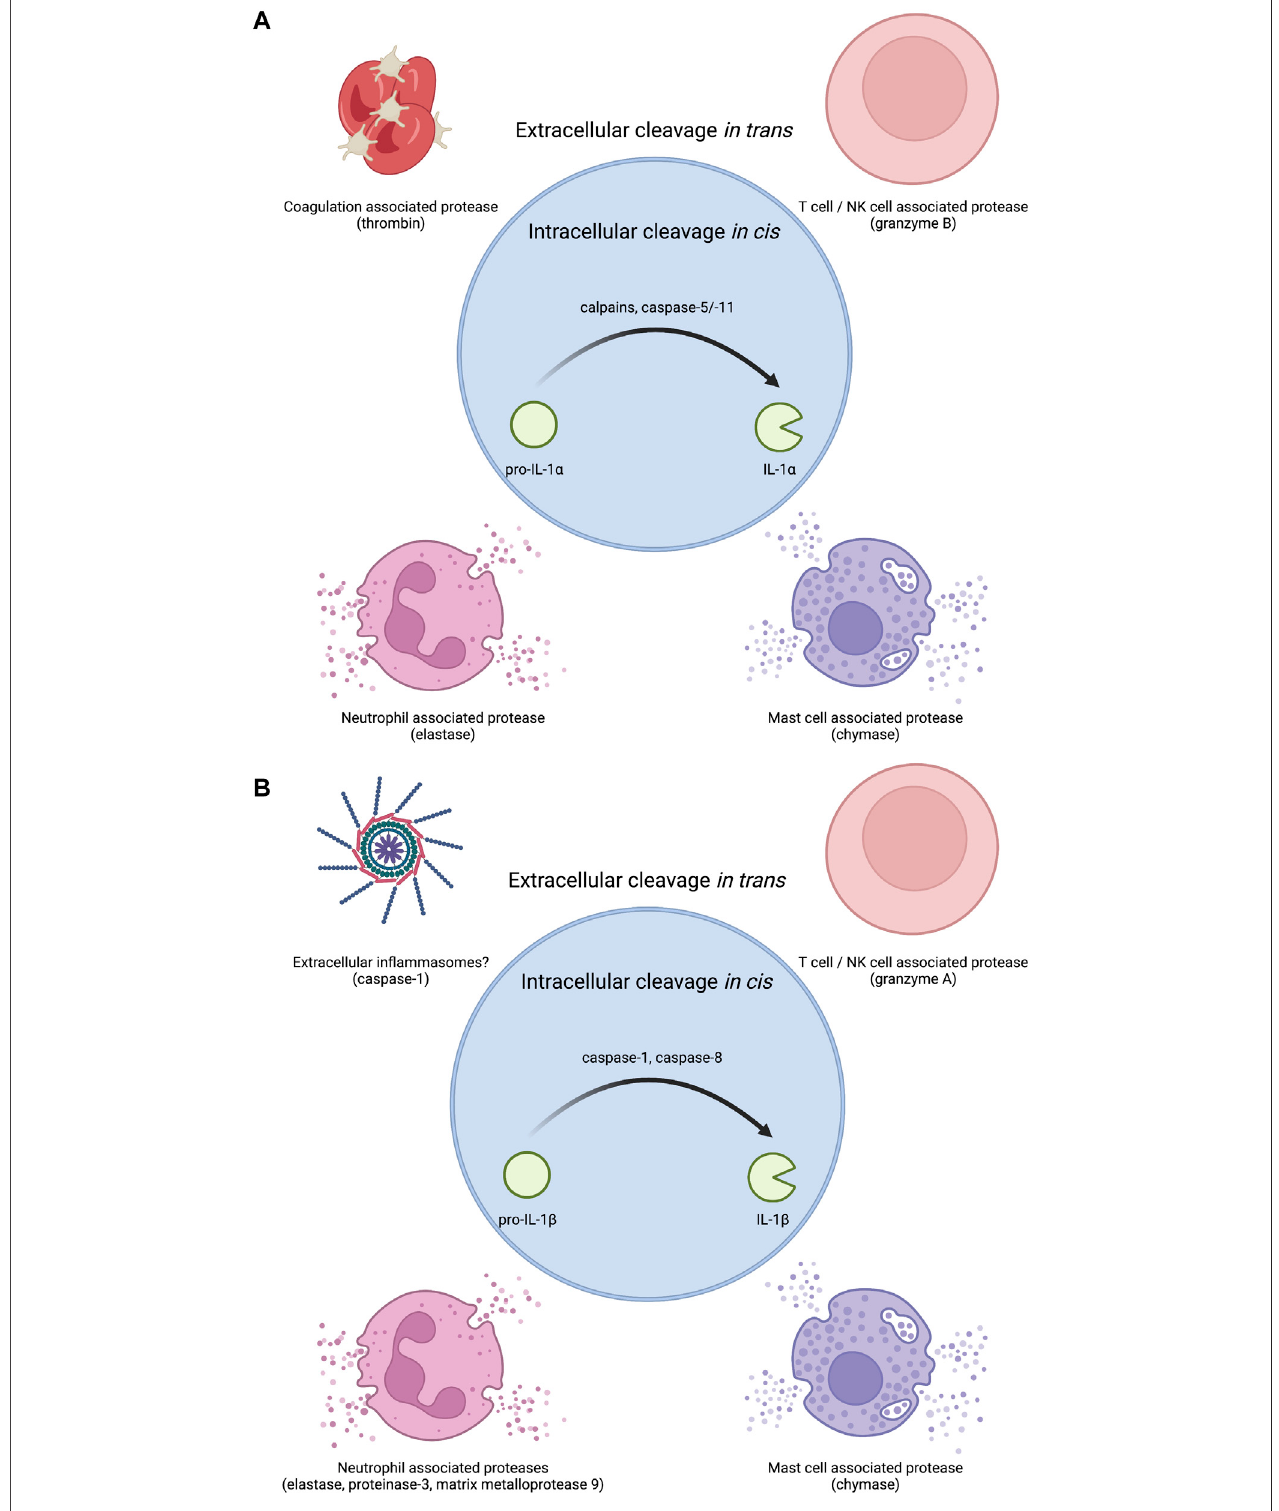
FIGURE 2 | Proteases that regulate IL-1 bioactivity in cis or in trans . (A) The precursor protein for IL-1 α is inherently bioactive. Several proteases have been shown to increase this bioactivity. Intracellular proteases that can regulate IL-1 α in cis include calcium activated proteases such as calpains as well as the non-canonical in fl ammasome associated caspase-5 and caspase-11 in human and mouse respectively. Extracellular proteases that can regulate IL-1 α in trans include coagulation